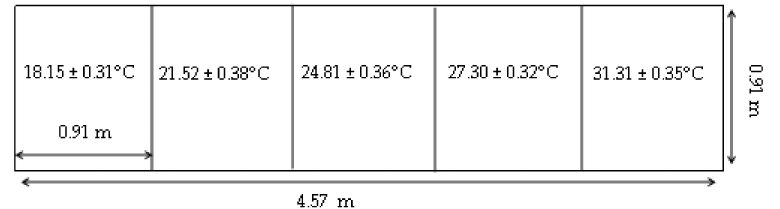
Figure 1. Scale drawing of one of two thermal apparatuses with thermal zones (mean ± SD temper- ature within each zone). Data loggers were placed 0.40 m and were in the middle of each thermal zone to calculate the average temperature of each zone.